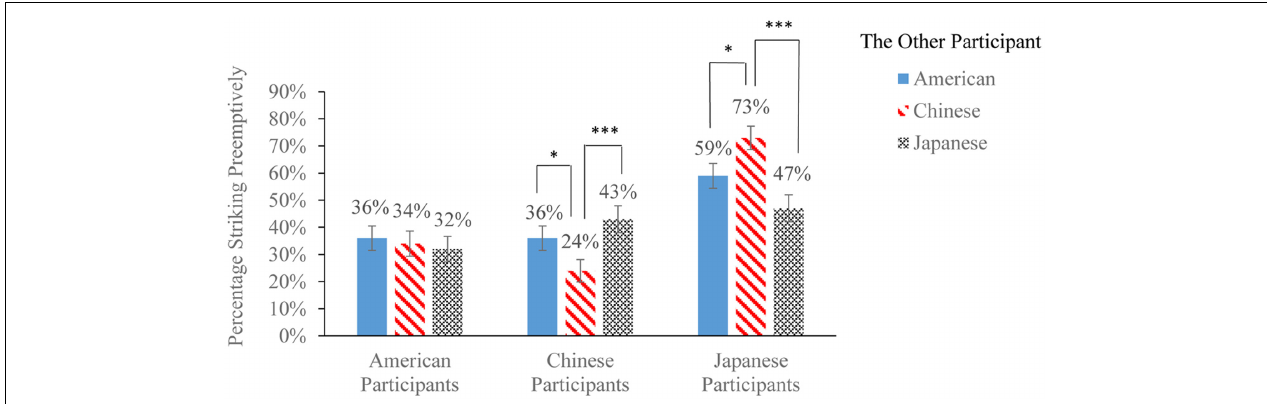
FIGURE 2 | Percentages of American, Chinese, and Japanese participants striking preemptively ( ± 1 SE) in the red-button PSG, facing a different participant from each of the three countries. All decisions were incentivized. ∗ p < 0.05; ∗∗∗ p < 0.001.